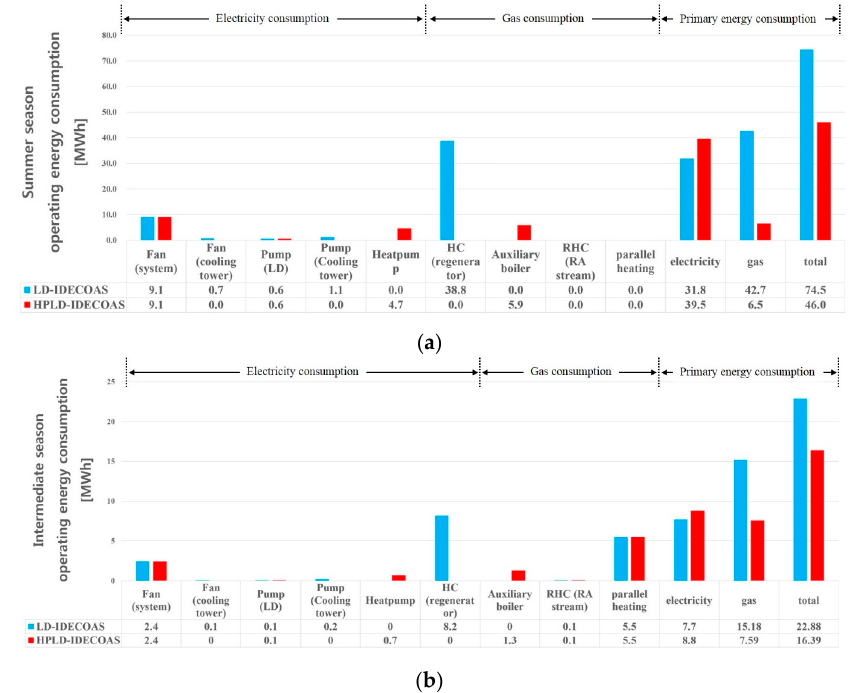
Figure 11. Comparison of seasonal operating energy consumption. ( a ) Comparison of operating energy consumption during the summer season; ( b ) Comparison of operating energy consumption during the intermediate season.